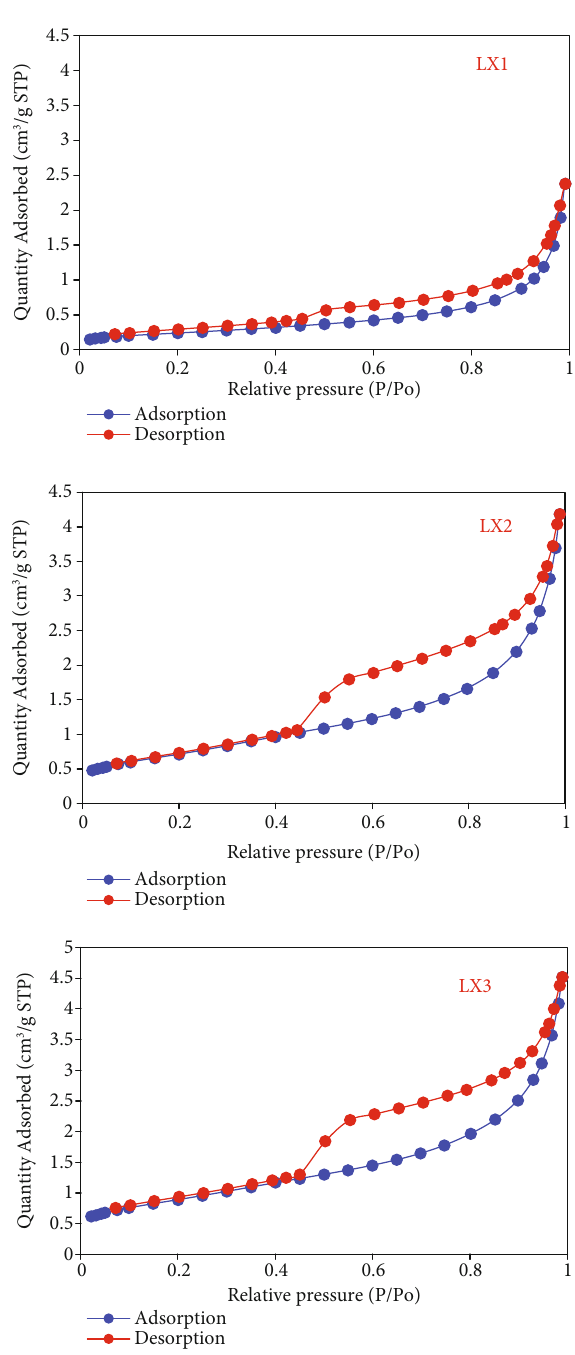
Figure 6: Nitrogen adsorption-desorption isotherms of the three